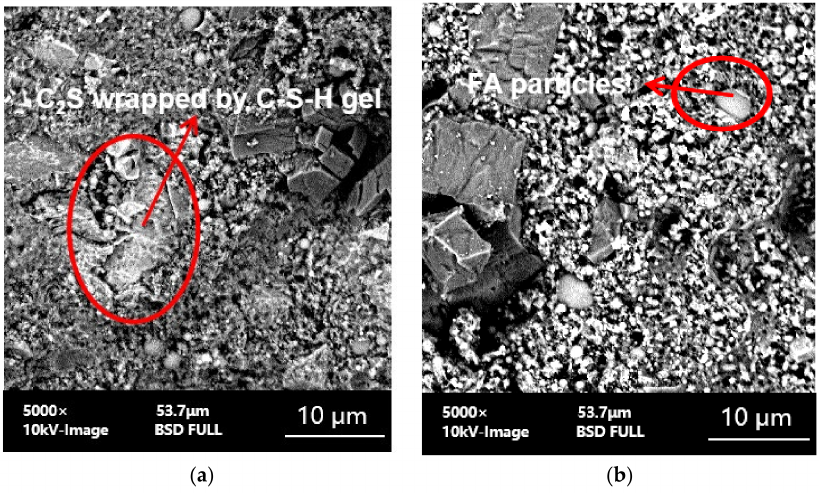
Figure 13. SEM images of UHPC based on composite cementitious material: ( a ) A4, ( b )